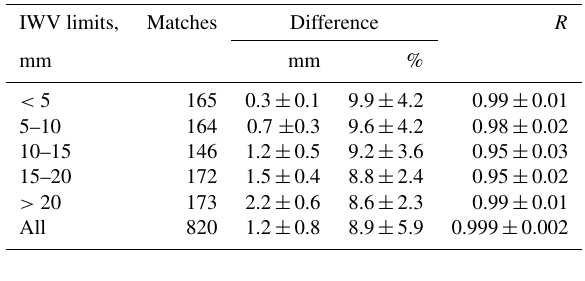
Table 4. Statistics of synchronised IWV pairs (M type and A type) for different IWV values. Relative differences (mean ± SD) in per- cent have been calculated with respect to the M-type values. R is the correlation coefficient.